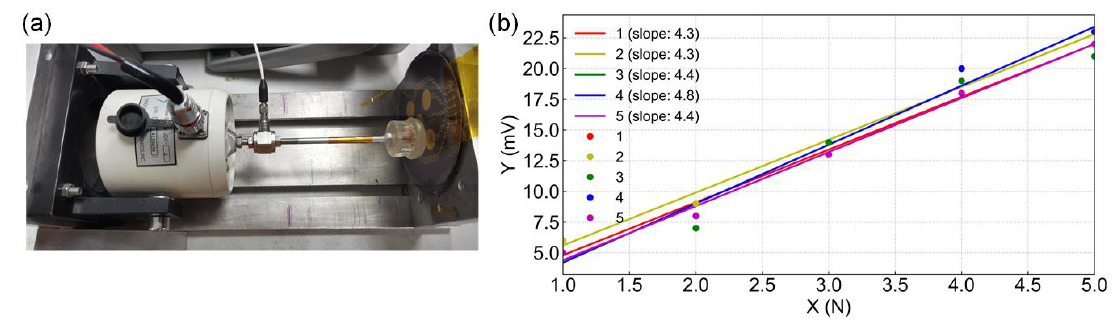
Figure 4. ( a ) Photograph of the experiment platform of the positive compression test; ( b ) The peak-to-peak voltage of the sensor unit at different pressure of the exciter, and their least squares linear fitting results.